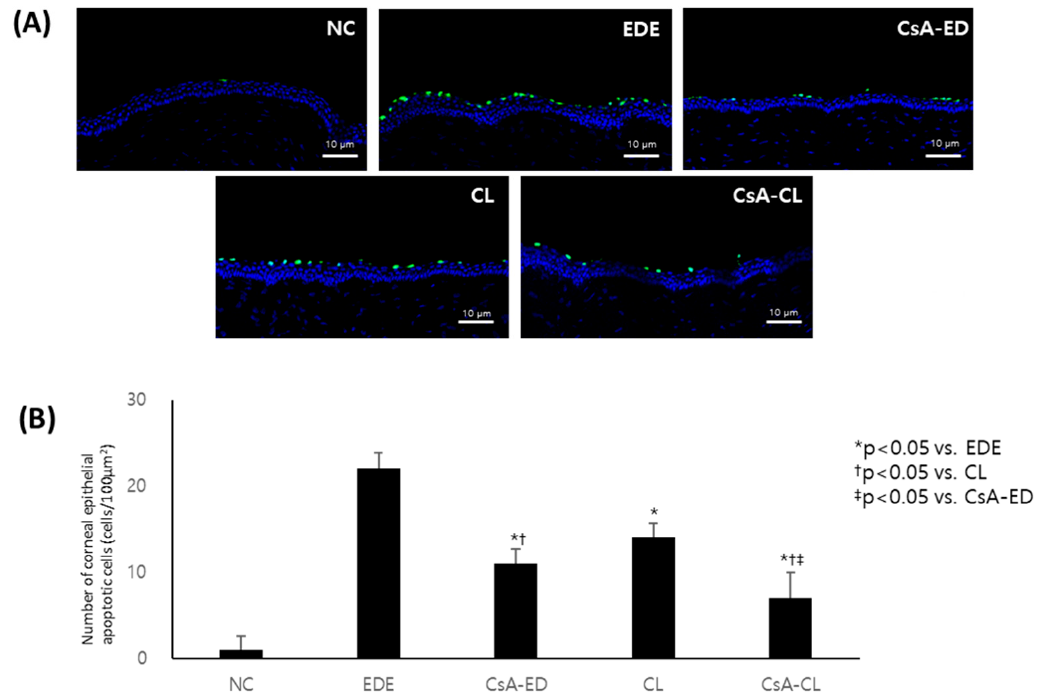
Figure 7. The representative images of corneal tissues at 14 days stained with TUNEL (green) and counterstained with DAPI (blue) ( A ) and the density of apoptotic cells in the samples ( B ). All data are presented as mean and SD. NC: normal control; EDE: experimental dry eye; CsA-ED: cyclosporine A eye drop; CL: contact lens; CsA-CL: cyclosporine A-loading pH-responsive contact